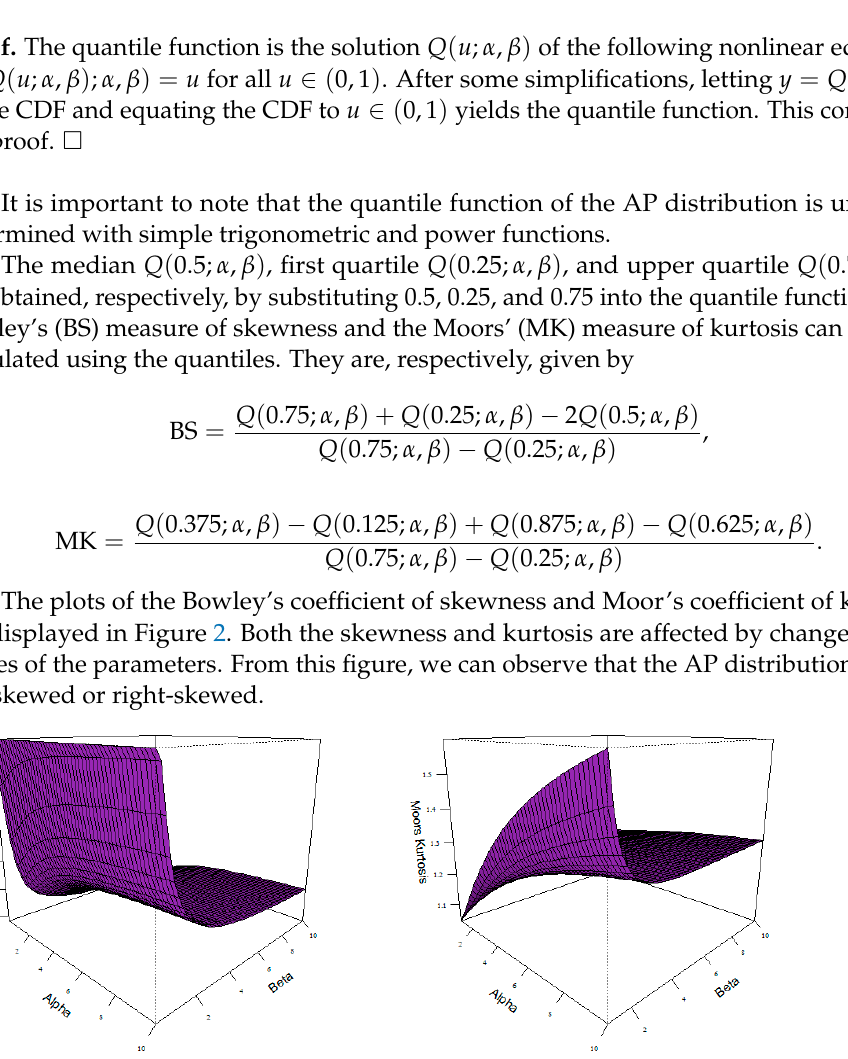
Figure 2. Skewness ( left ) and Kurtosis ( right ) plots.